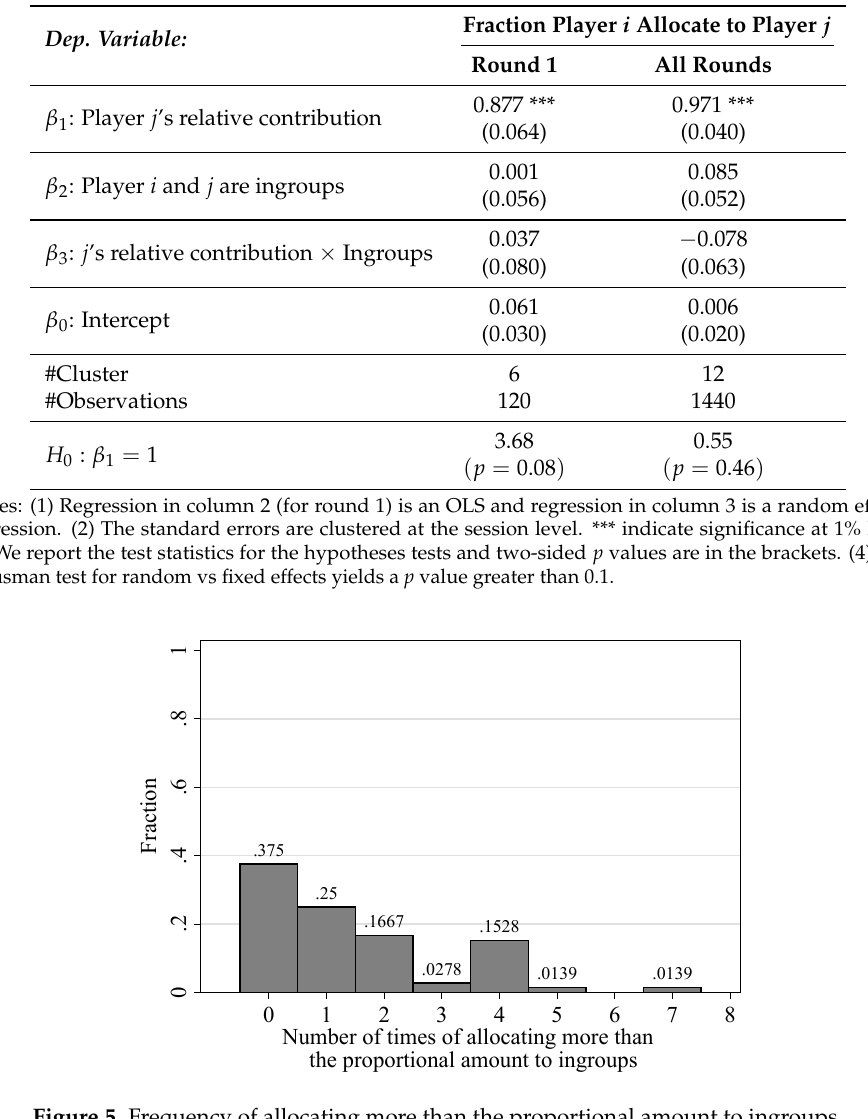
Figure 5. Frequency of allocating more than the proportional amount to